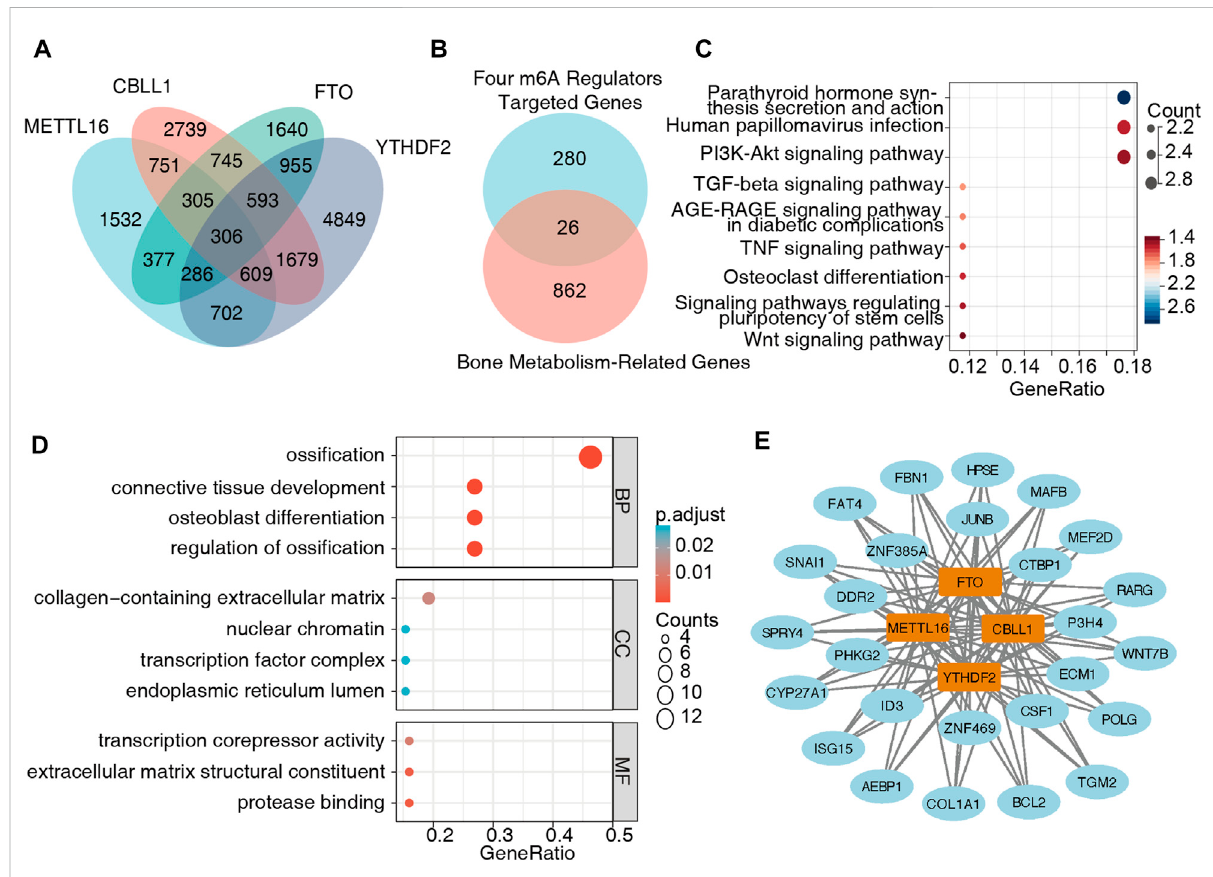
FIGURE 8 Creation of a regulatory network of m6A regulators-m6A target genes. (A) m6A target genes were obtained from M6A2Target, and 306 genes werepotentiallycoregulatedwiththefourm6Aregulators. (B) Twenty-sixm6Atargetgeneswerealsocloselyrelatedtobonemetabolism. (C) KEGG pathway analysis showed that these 26 genes were mainly enriched in parathyroid hormone synthesis, secretion, action, human papillomavirus infection,andtheP13K-AKTsignalingpathway. (D) TheGOanalysisindicatedthatthebiologicalprocessesofthesegenesweremainlyenriched in ossi fi cation, regulation of ossi fi cation, connective tissue development, and osteoblast differentiation. (E) A regulatory network was built with four hub m6A regulators and 26 m6A target